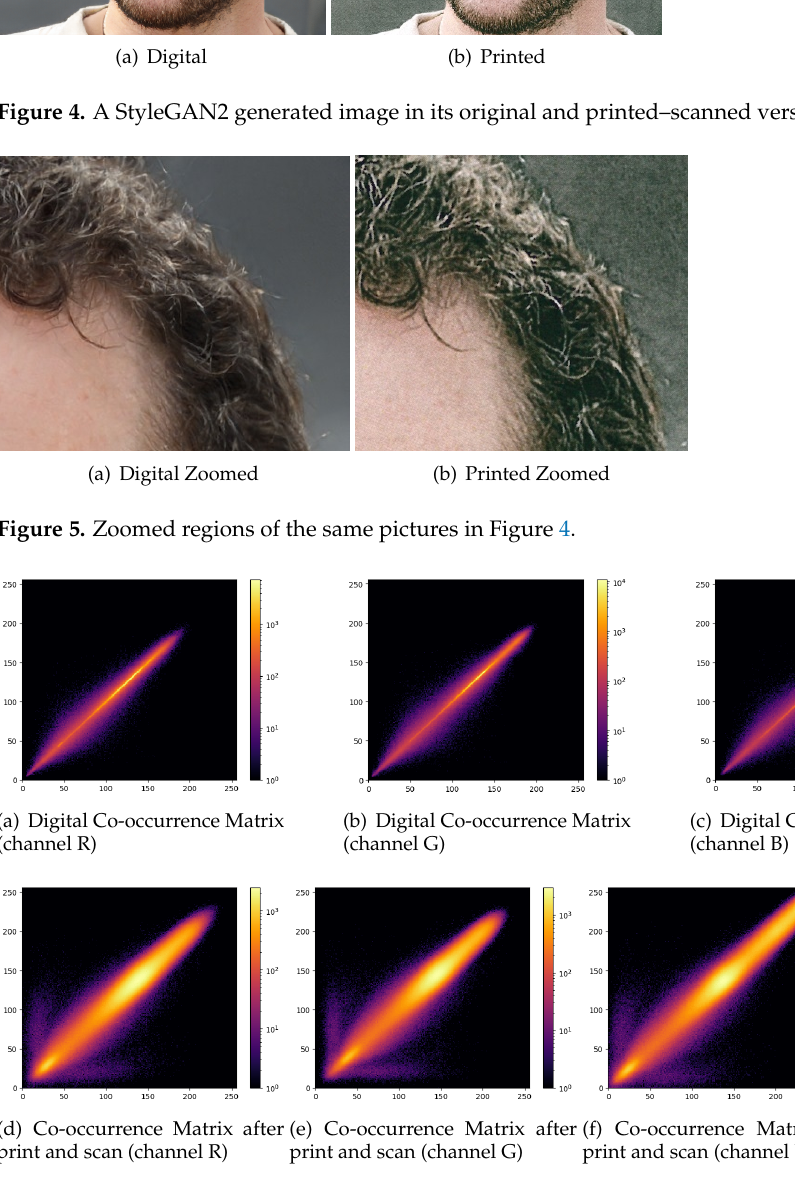
Figure 6. Co-occurrence matrices proposed in [39] to discriminate GAN-generated images from natural ones and their behavior in digital and printed and scanned images: ( top ) GAN image co- occurrence matrices in the digital format ( bottom ); GAN image co-occurrence matrices after printing and